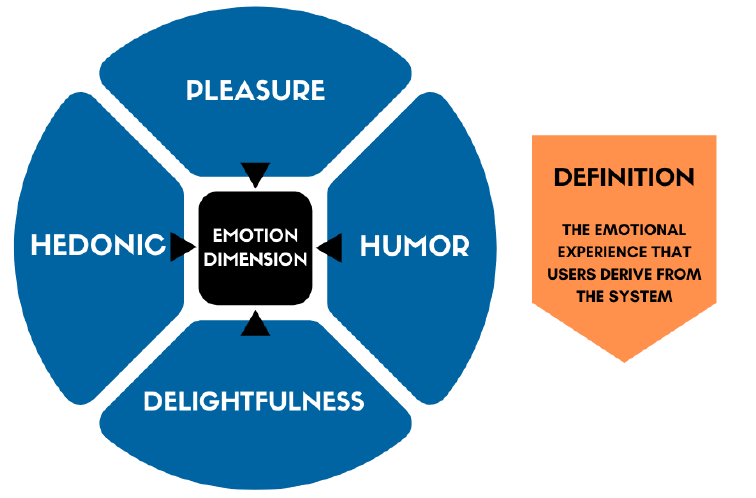
Figure 1. Example of the emotion dimension